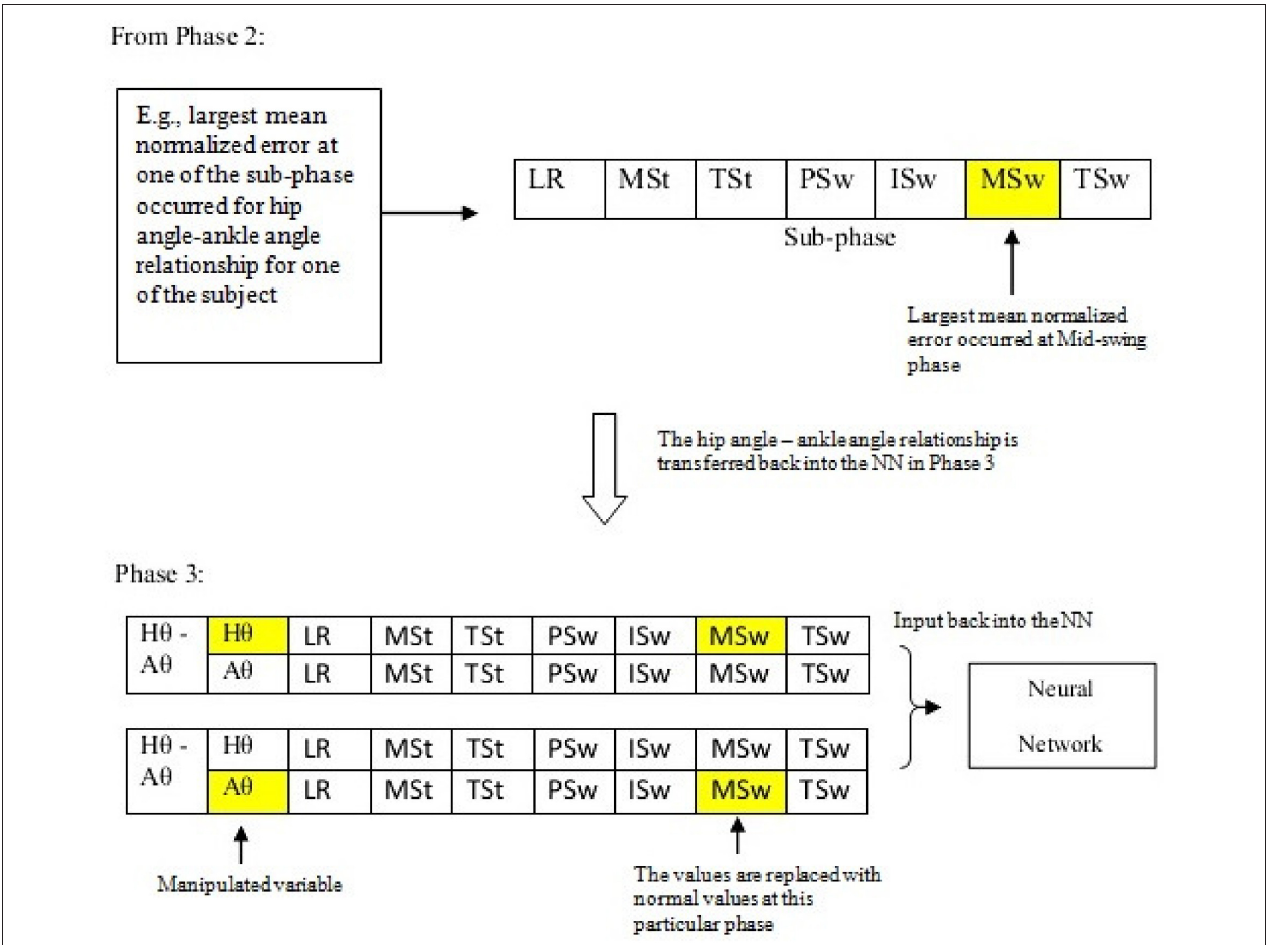
FIGURE 4 | The workflow of transferring the results from Phase 2 and Phase